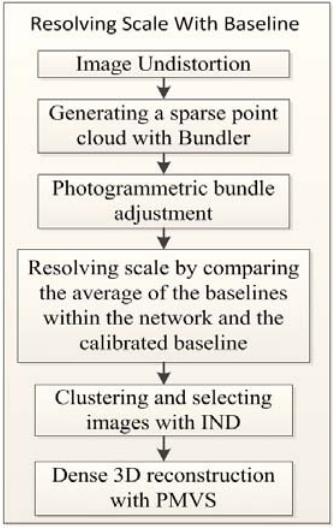
Figure 8. Generating a dense point cloud from the image set. The original images were analysed in VisualSFM to generate a dense point cloud. This software package includes bundler, cluster multi-view stereo (CMVS) and patch-based multi-view stereo (PMVS). The resulting point cloud was too sparse to discriminate 3D features on the ceiling due to insufficient textured area in the images. In order to improve the quality of images, corrections were applied to the images to remove geometric distortion caused by the camera lens. These included optical aberration (radial and tangential lens distortions) and axial displacements of the lens with respect to the sensor (offset of principal points from the image centre, affinity and orthogonality). Corrected images were again analysed in VisualSFM , and a photogrammetric multi-view stereo method was applied to the corrected images to resolve the scale.